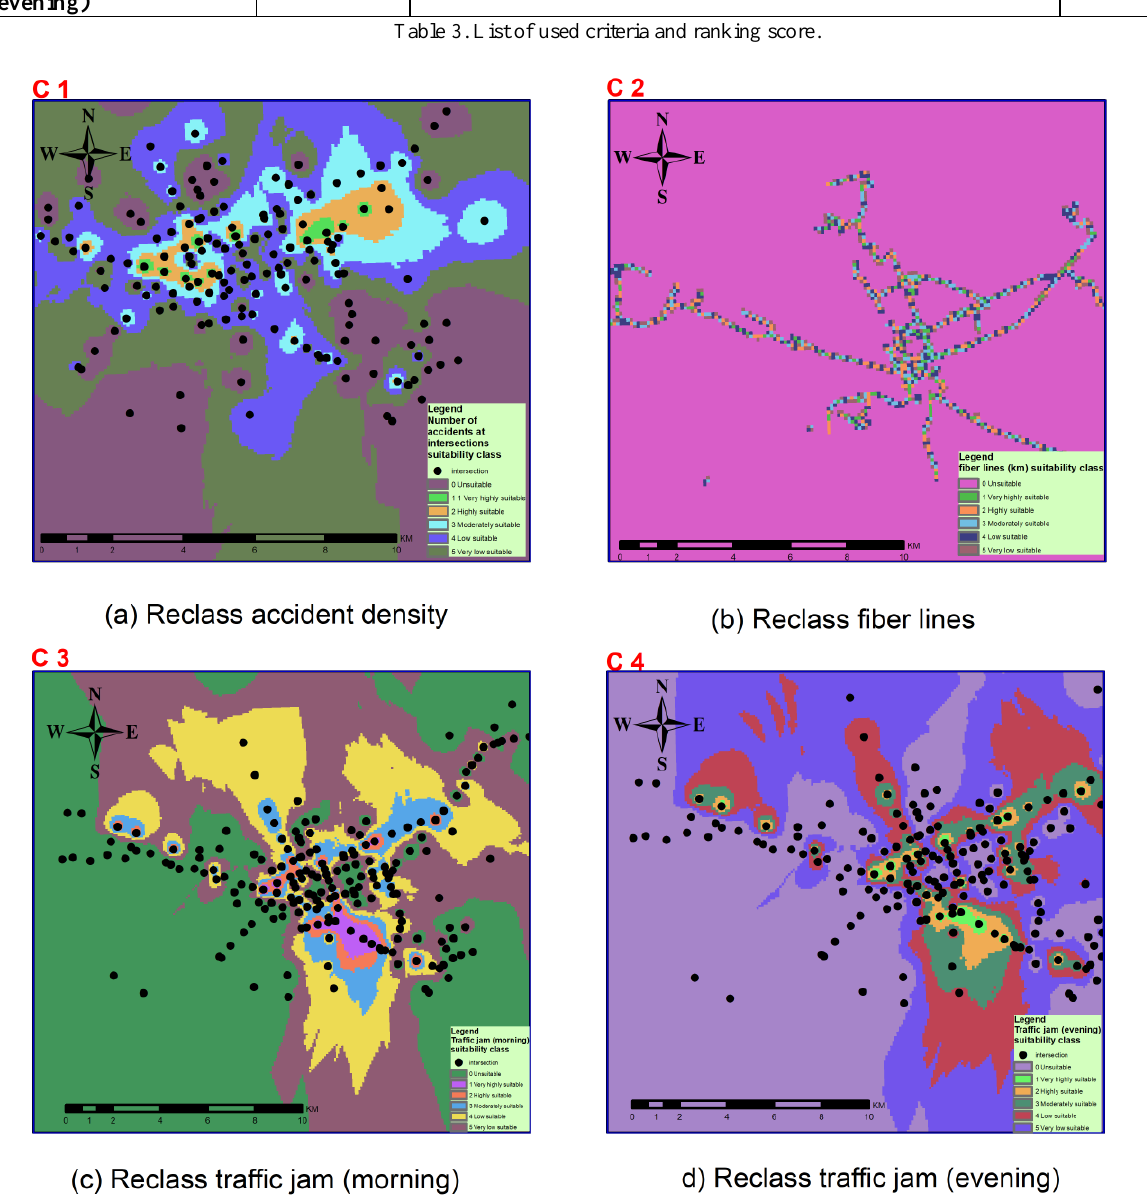
Figure 4. Reclassification maps used for four